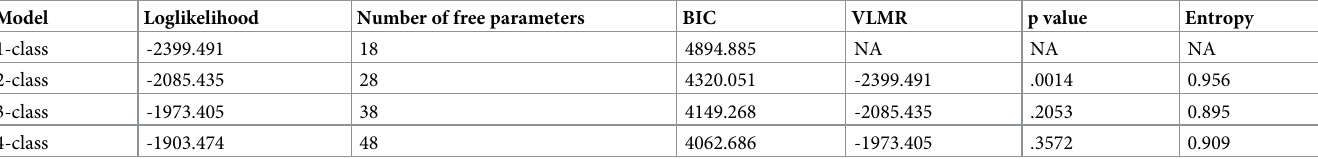
Table 1. Fit indices for models with 1, 2, 3, and 4